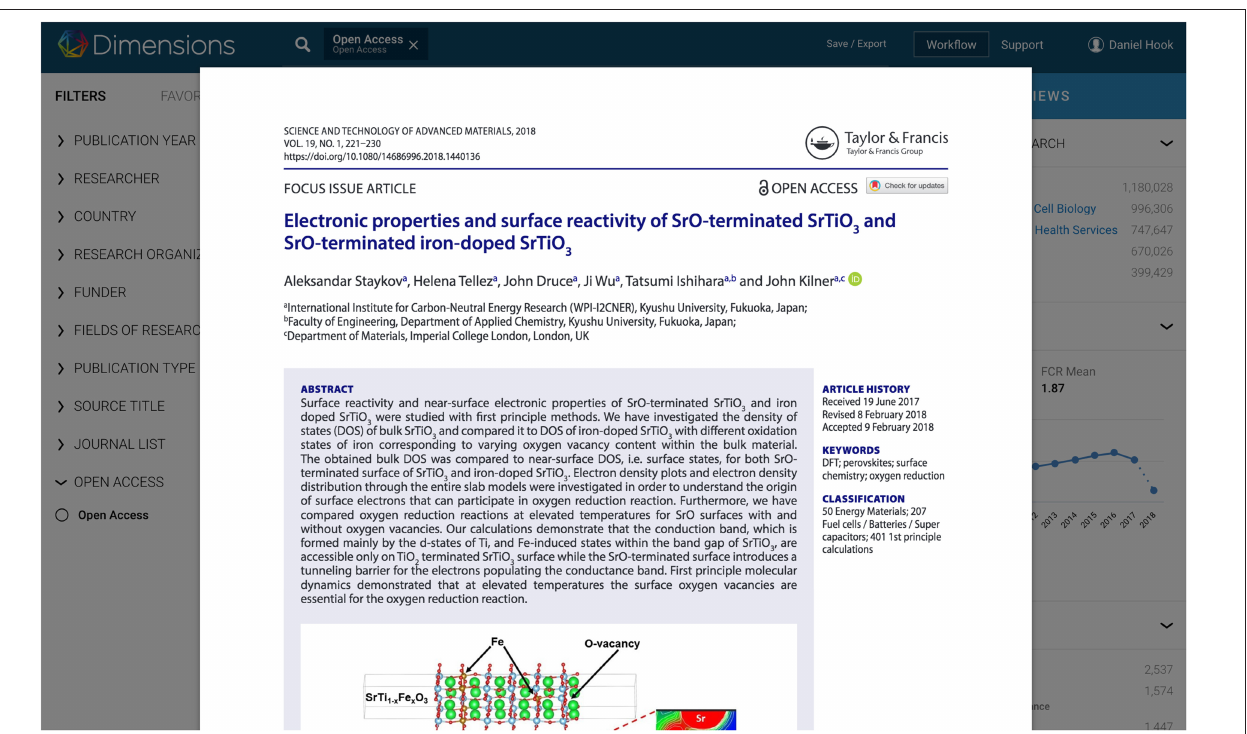
FIGURE 5 | Anywhere Access functionality. Wherever a user sees a “View PDF” link against a record in Dimensions, they are able to load a full text copy of that publication in the browser directly, using ReadCube’s viewer technology. If the user has a ReadCube account then they can directly add the paper to their library. This functionality allows the user to be one click away from content. In the free version of Dimensions, open access content is delivered seamlessly in this way. In the paid version of Dimensions organizational holdings information can be integrated to ensure that all content under subscription can be reached in one click by a user, even if they are traveling and are away from their home